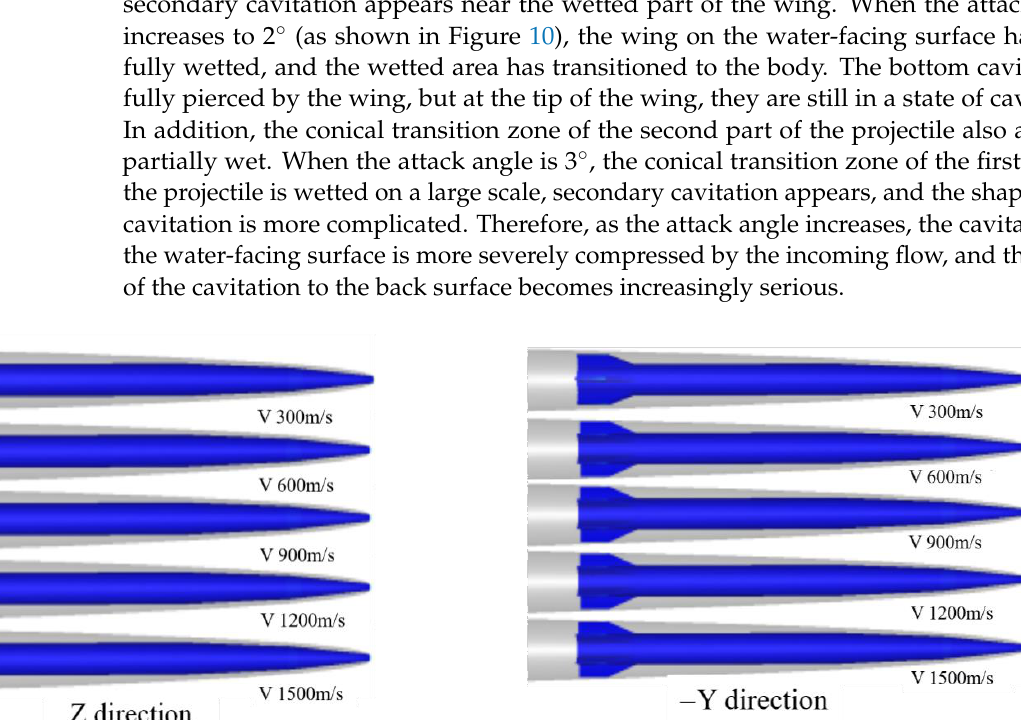
Figure 7. The drag coefficient obtained by using different density grids.